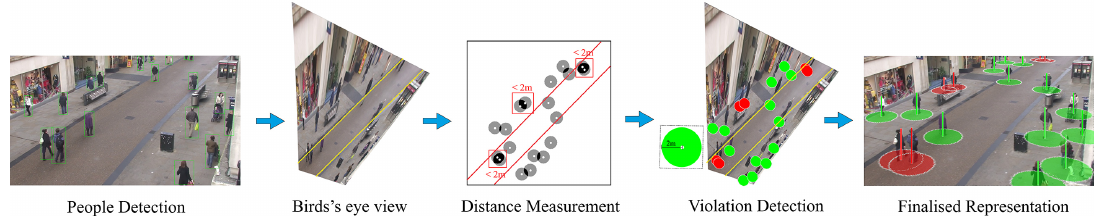
Figure 13. The summary of the steps taken in Sections 3.1–3.3 for people detection, tracking, and distance